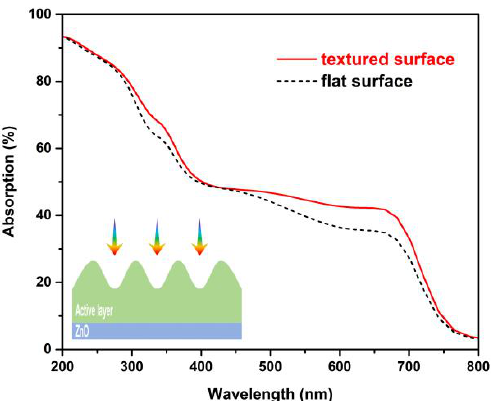
Figure 5. Absorption spectra of the blend films with textured and flat surfaces. The photons are incident from the top of the active layer as demonstrated in the inset.